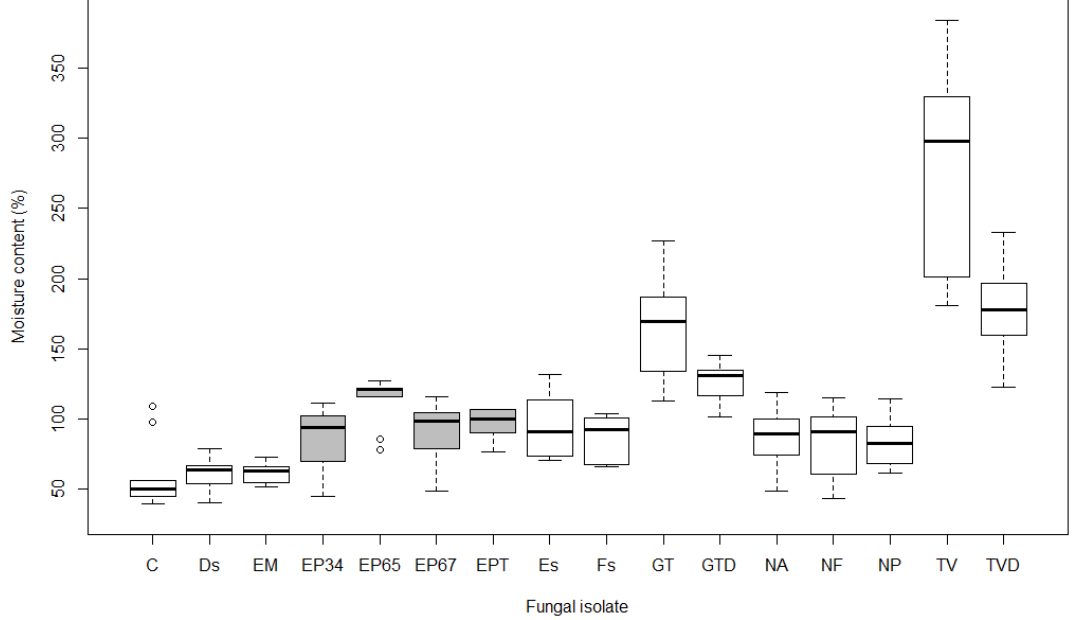
Figure 6. Boxplots showing moisture content (%) after 15 weeks of exposure to different fungal isolates in Acer campestre (see Table 1 for labels of isolates; boxes of E. parasitica isolates are grey). Boxplot represents minimum, first quartile (Q 1 ), median, third quartile (Q 3 ), and maximum value. The change in average moisture content ( ΔMC ) between samples exposed to fungal activity and control samples was positive for all fungal isolates and all maple species, except for A. platanoides exposed to EM, which showed a negative value (Table 2). Table 2. Change in average moisture content ( ΔMC ) of samples.